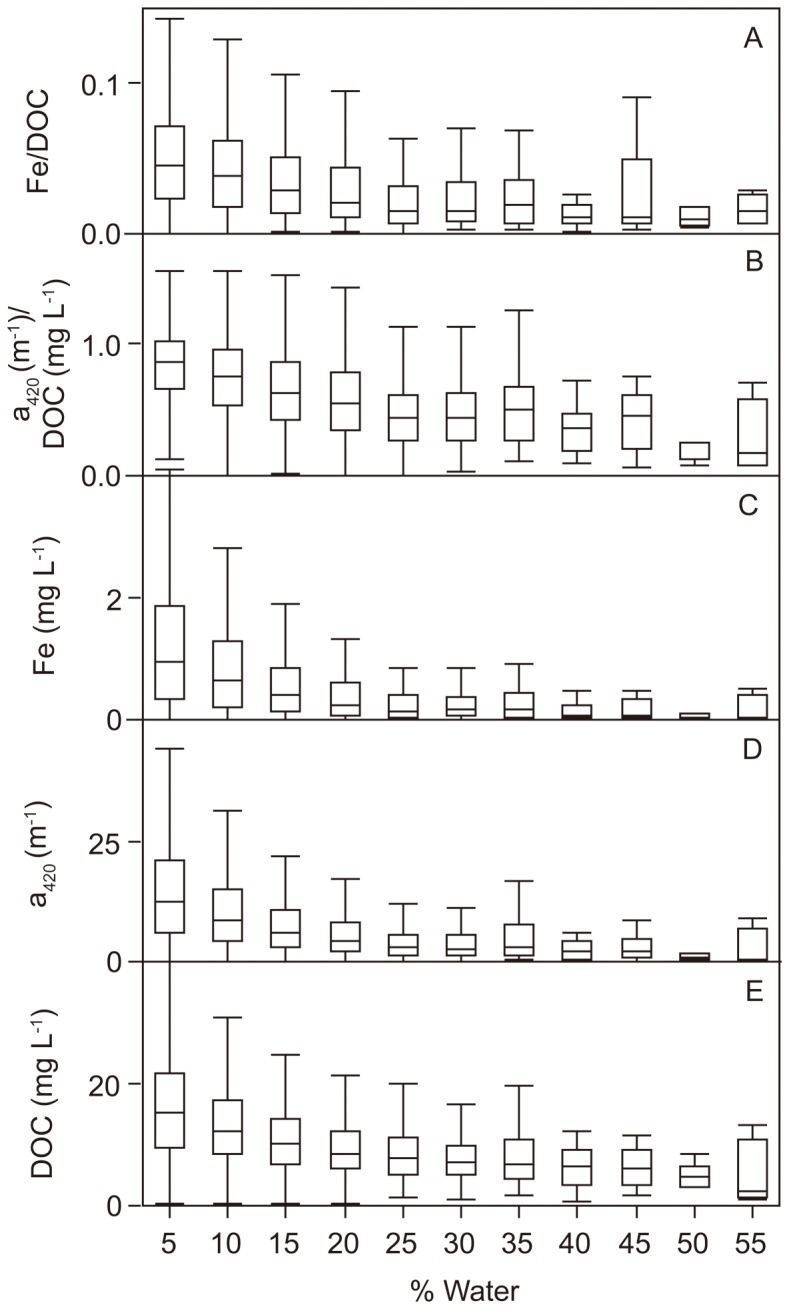
Iron (Fe), dissolved organic carbon (DOC), absorbance (a420), Fe/DOC and a420/DOC ratios in relation to the percentage of lake surface area in the catchment area (% Water).For the figure, site-specific long-term median data of 5837 different lakes and streams were used. Taking the median of each of the 11% Water categories and applying a simple exponential decay along the % Water gradient we received highly significant results (P<0.0001, n = 11; R2 = 0.78 for Fe/DOC in panel A, R2 = 0.84 for a420/DOC in panel B, R2 = 0.95 for Fe in panel C, R2 = 0.89 for a420 in panel D and R2 = 0.88 for DOC in panel E).